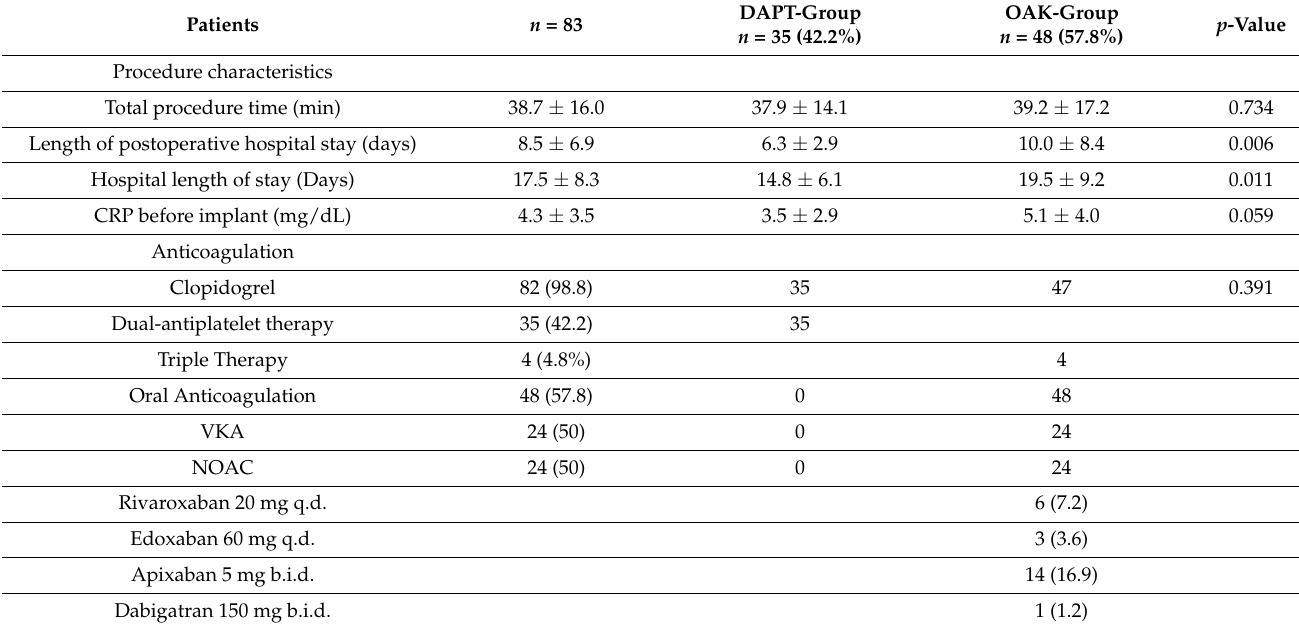
Table 4. Procedural characteristics and coagulation regimes of the study population (DAPT therapy vs. OAK therapy).